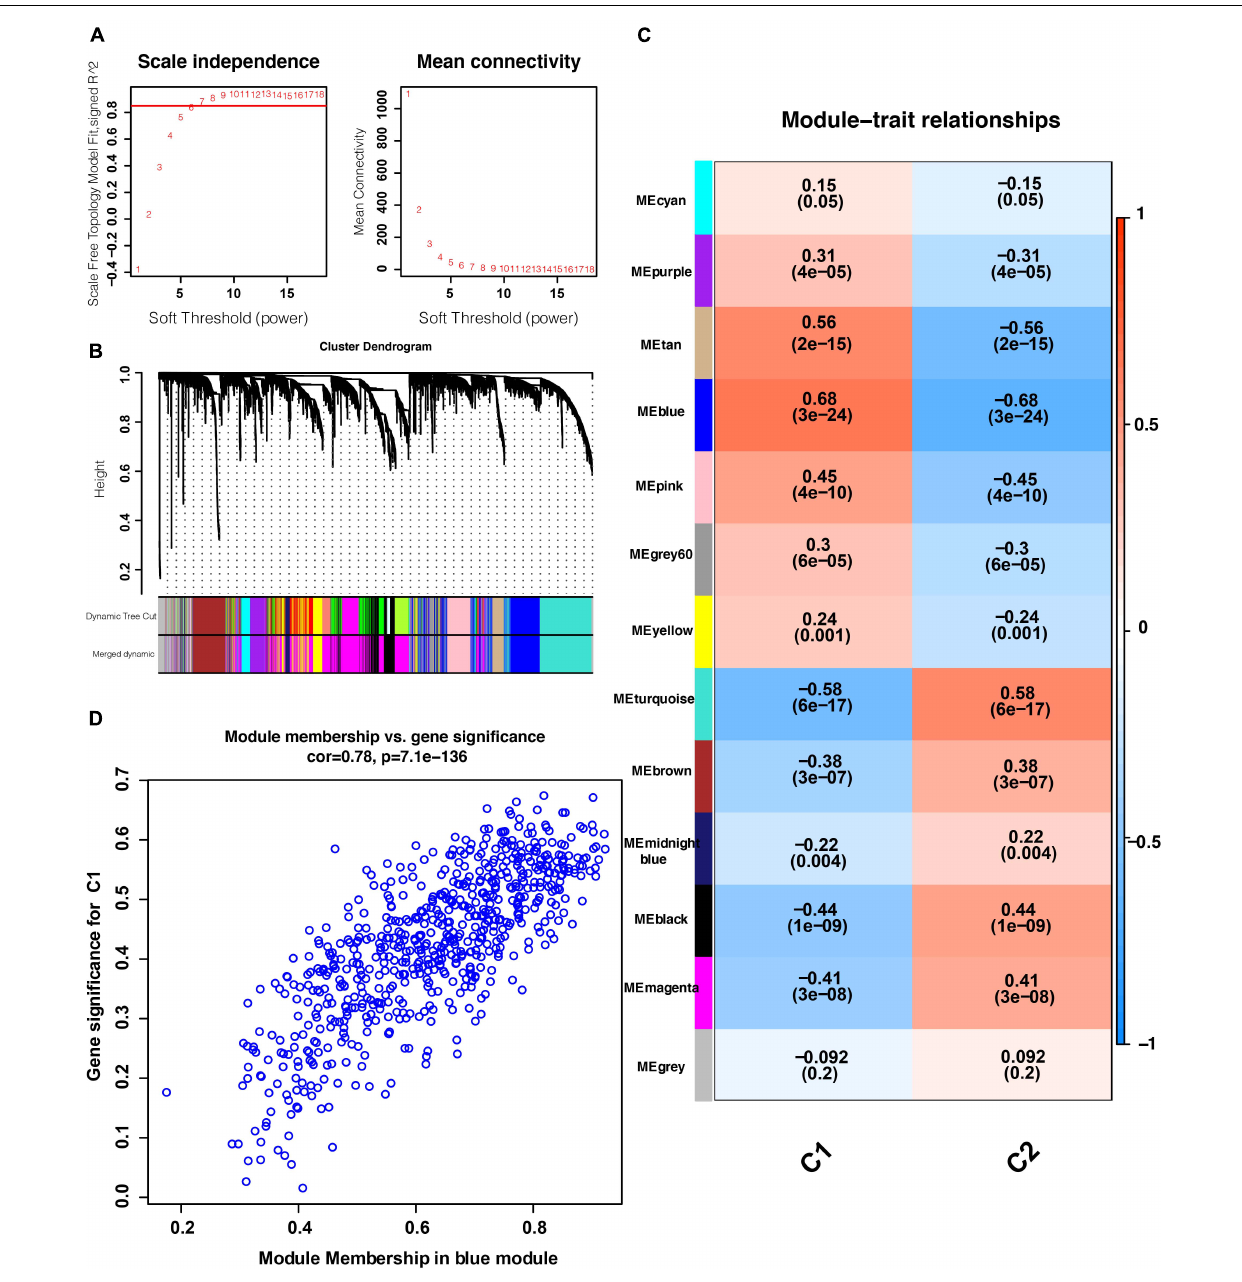
FIGURE 4 | WGCNA results. (A) Relationship between the soft threshold and TOM-based dissimilarity (left). Relationship between the soft threshold and mean connectivity (right). (B) After cutting and merging, 13 gene modules were finally generated. (C) Heat map of the correlations between gene modules and phenotypes. (D) Scatter plot depicting the correlations between gene significance and module membership of genes in the blue network. WGCNA: weighted correlation network analysis. TOM, topological overlap matrix. P < 0.05 is defined as statistically